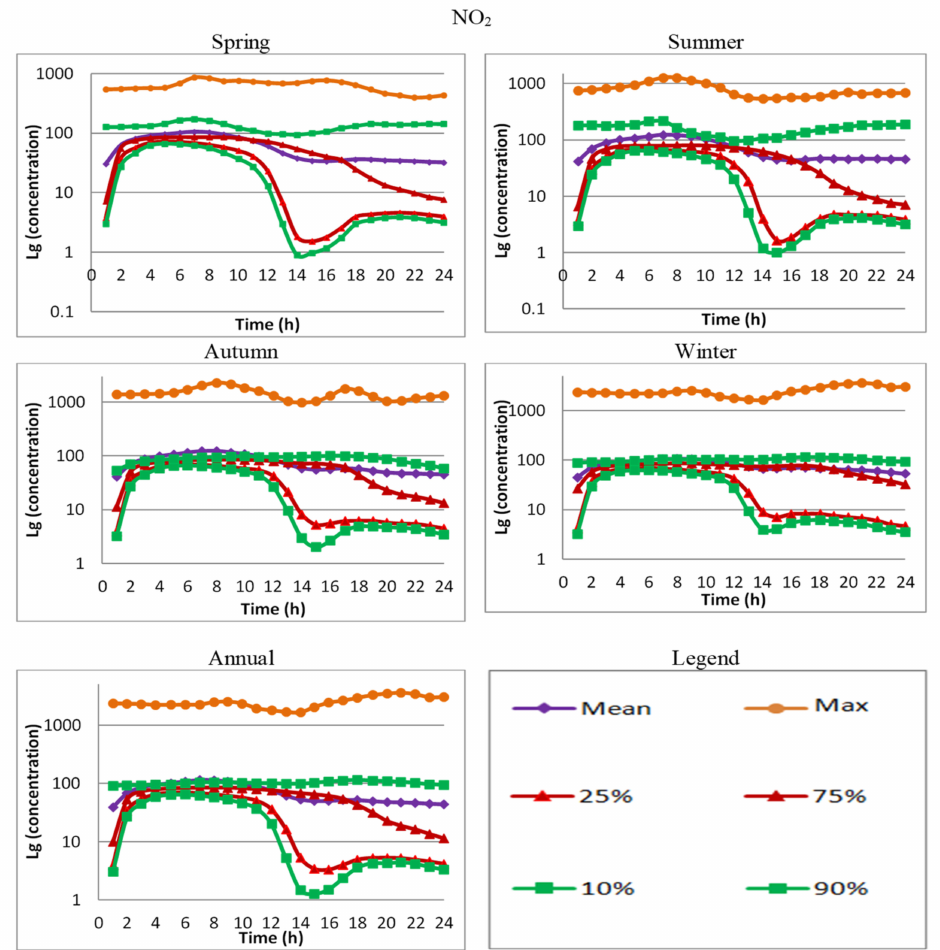
Figure 2. Spatial and diurnal variations of the annual and seasonal ensembles of surface NO 2 ( µ g/m 3 ) concentration behavior in logarithmic scale for Sofia for the period 2008–2014.